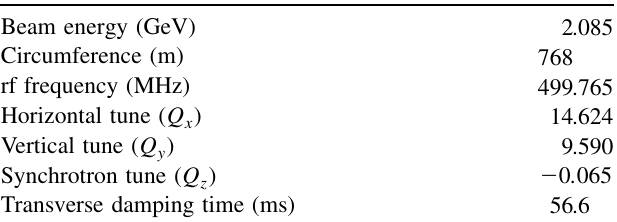
TABLE I. Machine parameters for IBS